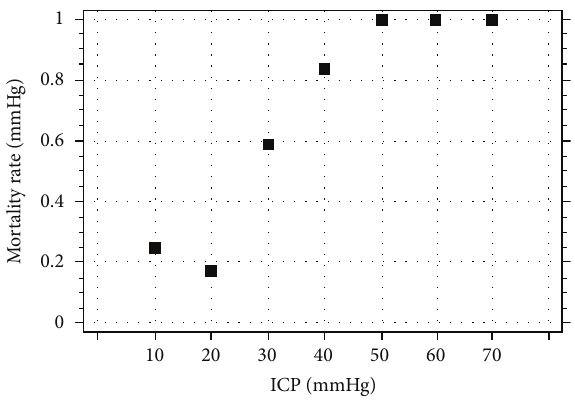
Figure 2: Correlation between mortality rate and ICP. General threshold between normal and elevated ICP between 20 and 30 mmHg. ICP: intracranial